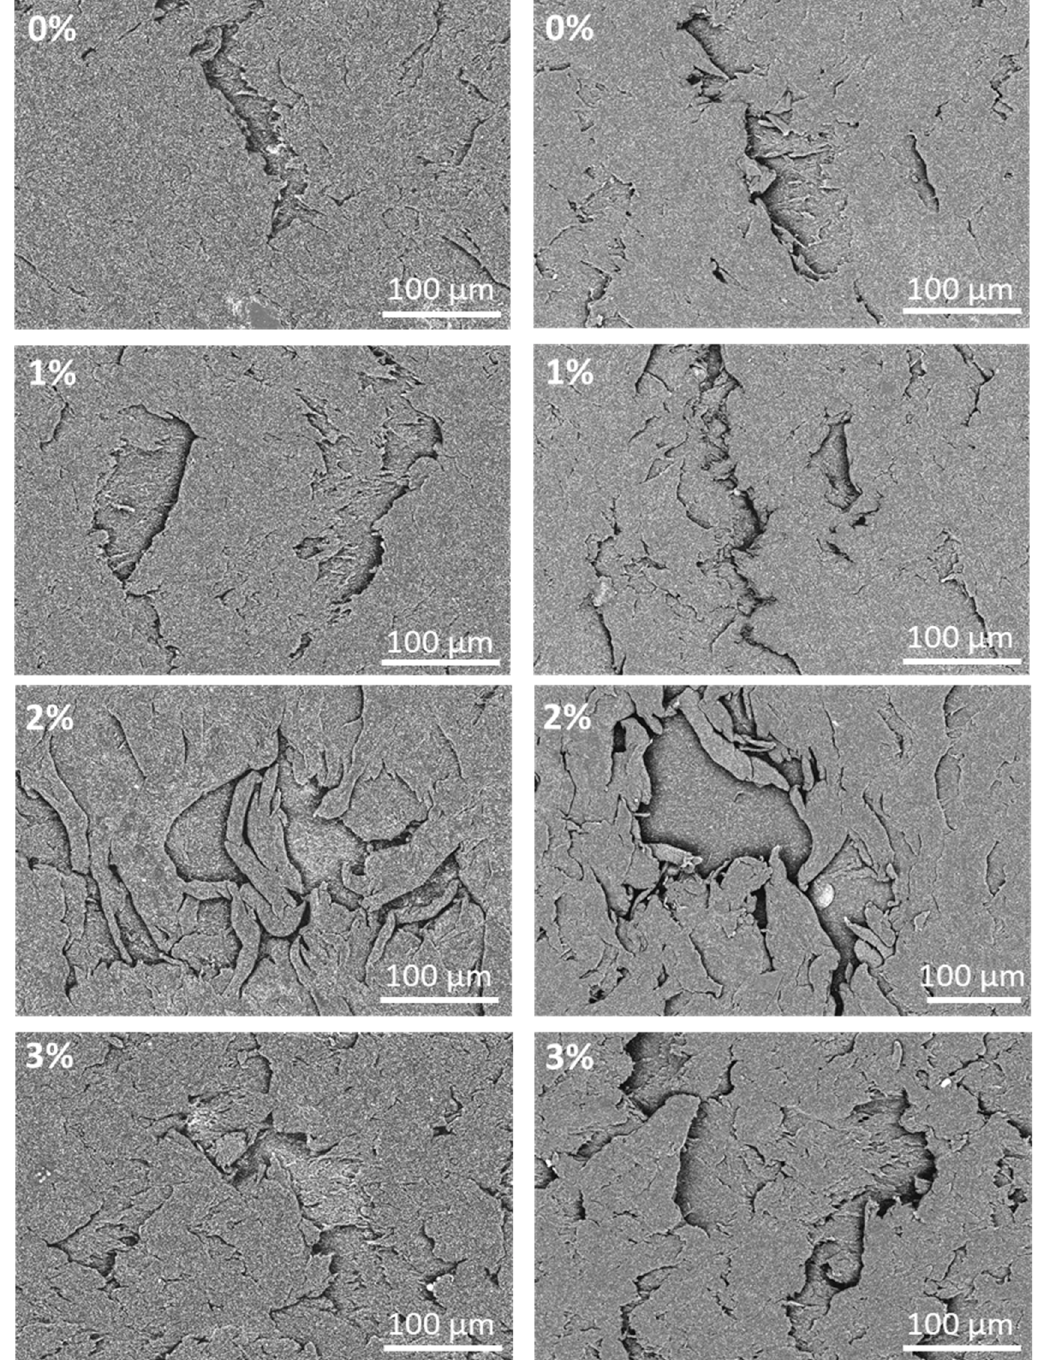
Figure 11. SEM micrographs showing the details of wear damages of all PA11 coatings at 0 h ( left ) and 500 h ( right ) of exposure (magnification ×300).